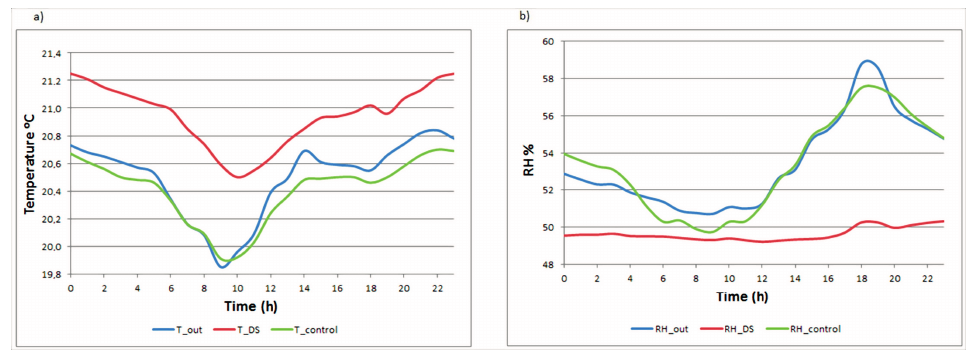
Figure 12. Mean daily trajectories of sensor inside the display cabinet (red), sensor at the outside of the display cabinet (blue) and control data-logger at the outside of the display cabinet (green). ( a ) Temperature; ( b )